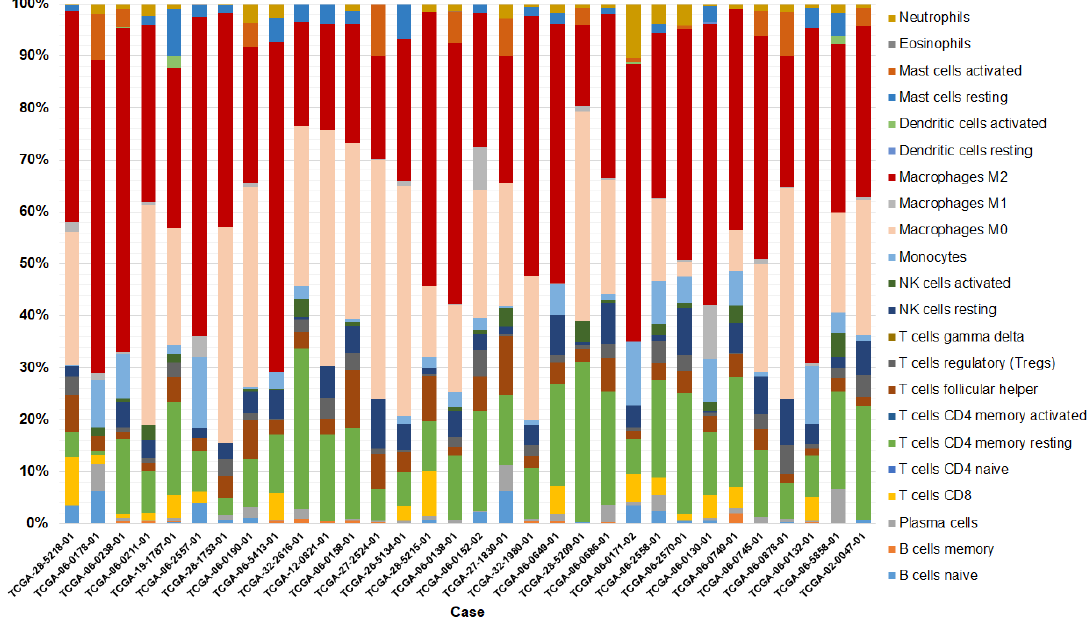
Figure 4. Profiling of infiltration of immune cells into GBM. Deconvoluted immune cell subsets from The Cancer Genome Atlas (TCGA) data by CIBERSORT indicate NK cells represent up to ~9.48% of GBM immune infiltrates. Data have been trimmed to include cases for which gene expression was p < 0.05.